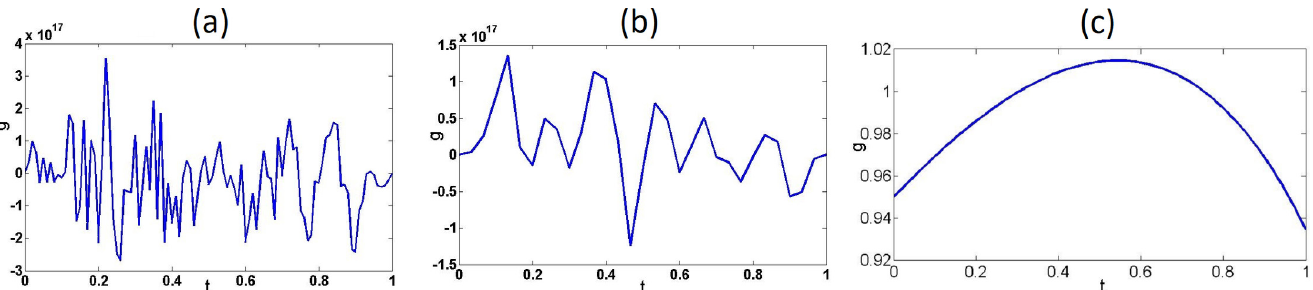
Fig 2. Solutions to the system in Eq (8). Approximate solutions without regularization for (a) n = 100 and (b) n = 30. (c) Approximate solution with regularization for n =